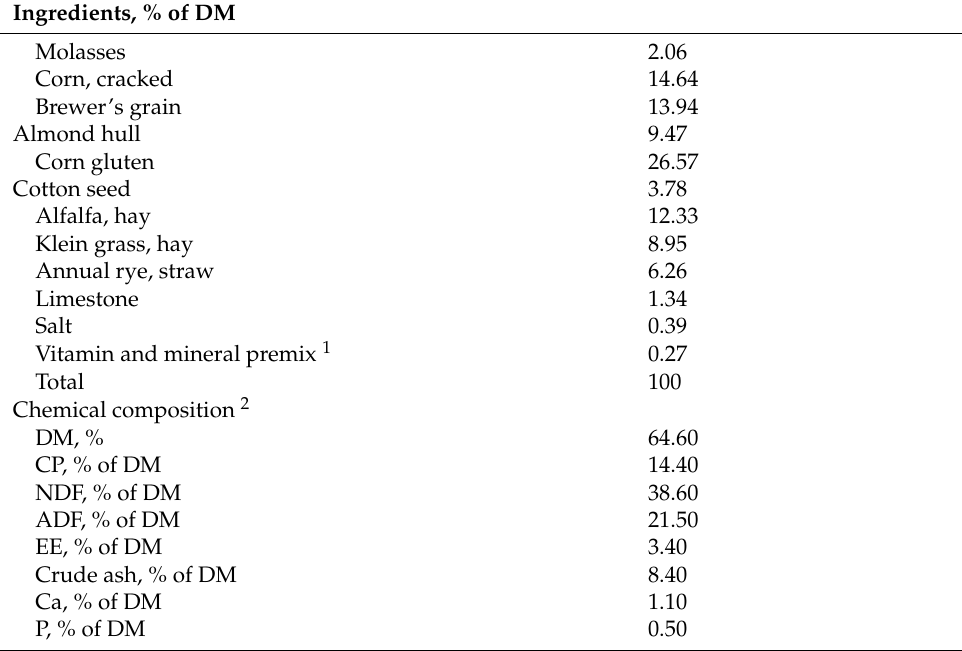
Table 1. Diet ingredients and chemical compositions.